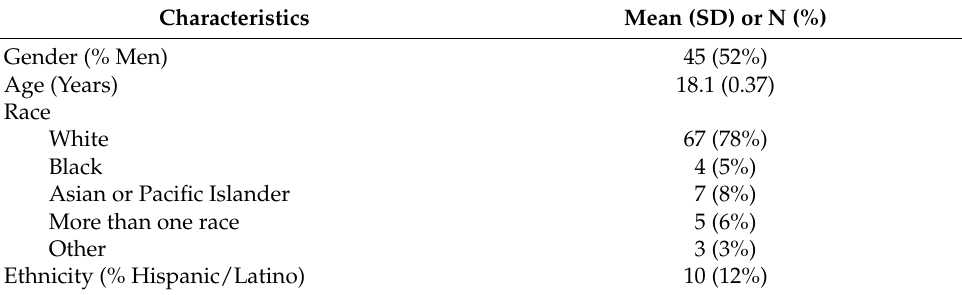
Table 1. Demographic characteristics of participants (N = 86).